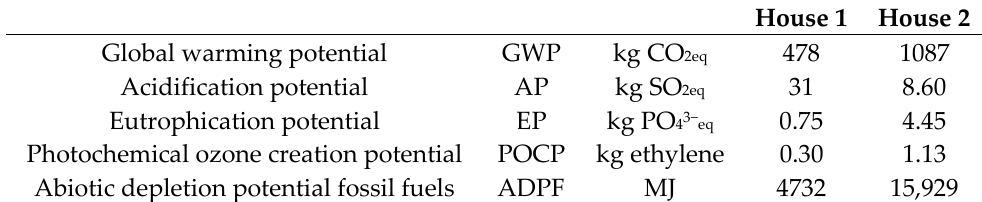
Table 1. Characteristic impacts on m 2 of the total floor area of a family houses.